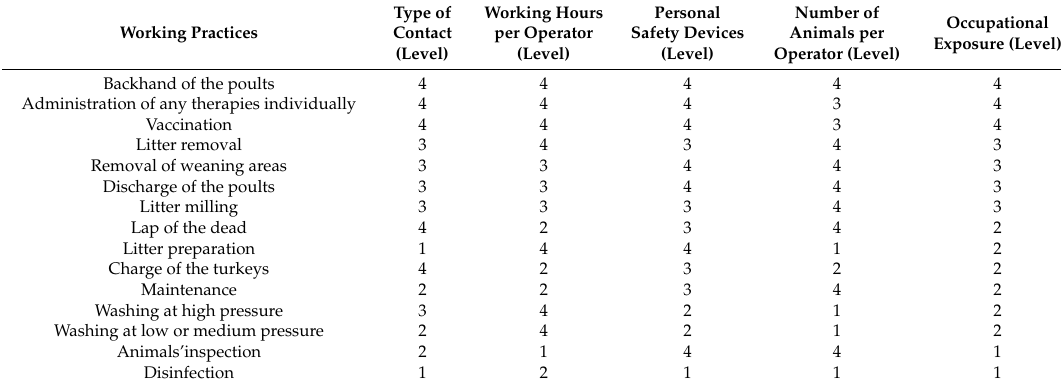
Table 9. Level of occupational exposure to MRSA in descending order for each of the working practices in the fattening turkey farming, as obtained by a modified FMEA. When two or more practices have the same ranking, they are ordered according to the tie-break rule.